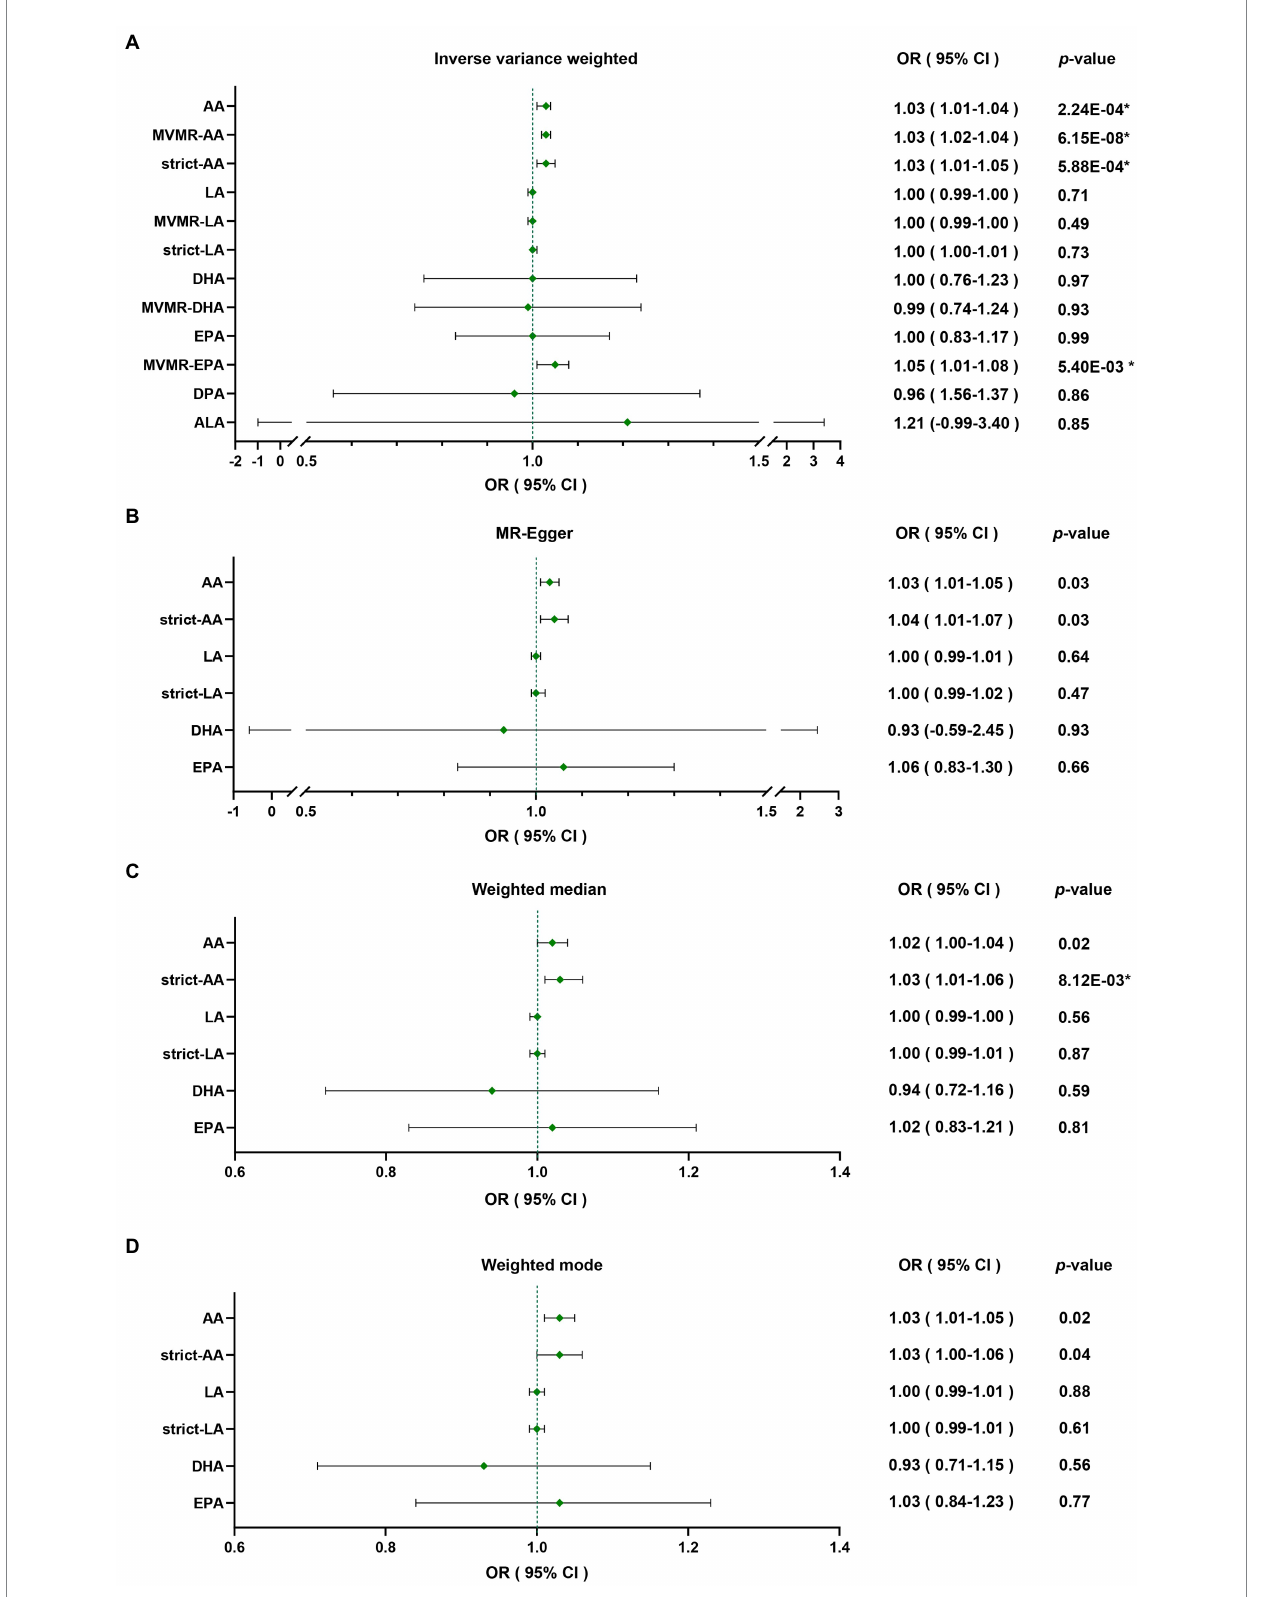
FIGURE 1 Forest map of inverse variance weighted, MR-egger, weighted median, weighted mode analyses: causal relevance between PUFAs and PD were analyzed through (A) Inverse variance weighted, (B) MR-Egger, (C) weighted median, (D) weighted mode. *Results with a significant p- value after false discovery rate correction. MR-Egger, Mendelian randomization Egger regression; MVMR, multivariable Mendelian randomization; OR, odds ratio; CI, confidence interval; AA, arachidonic acid; LA, linoleic acid; DHA, docosahexaenoic acid; EPA, eicosapentaenoic acid; DPA, docosapentaenoic acid; ALA, alpha-linolenic